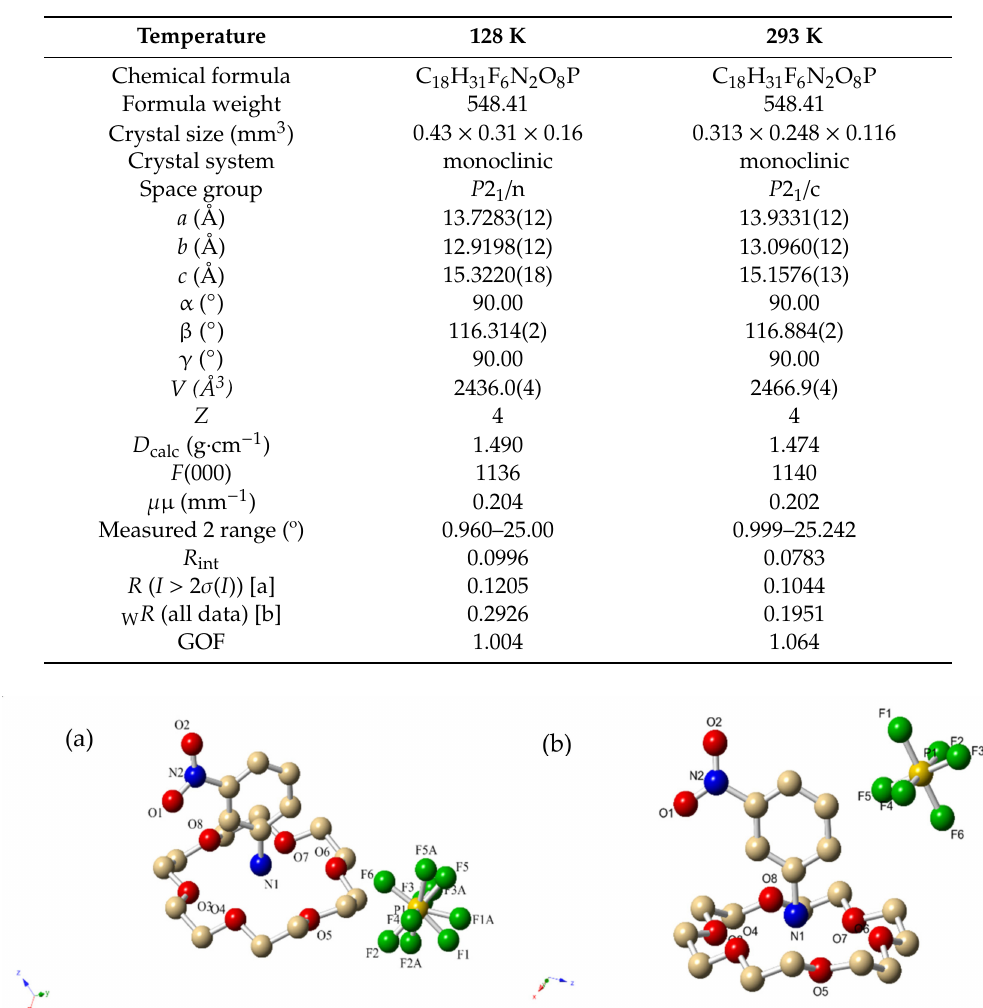
Table 1. Crystallographic data for 1 at 128K and 293K.